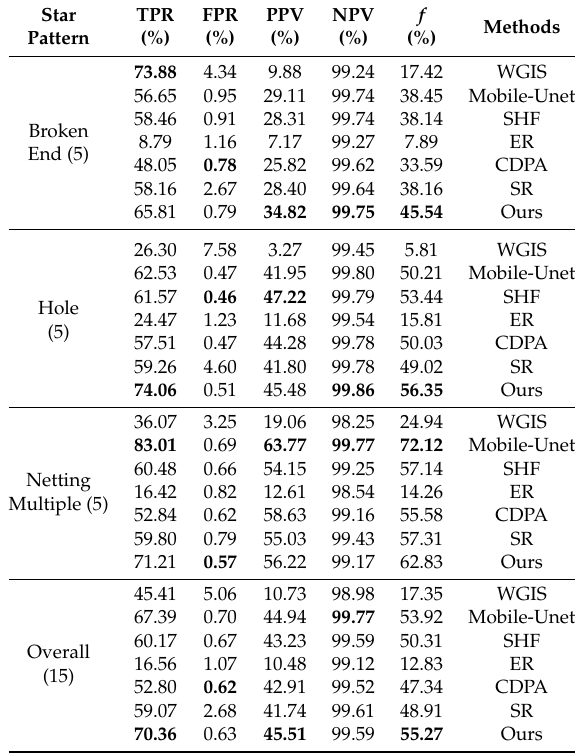
Table 1. Numerical results of each defect type for star-patterned